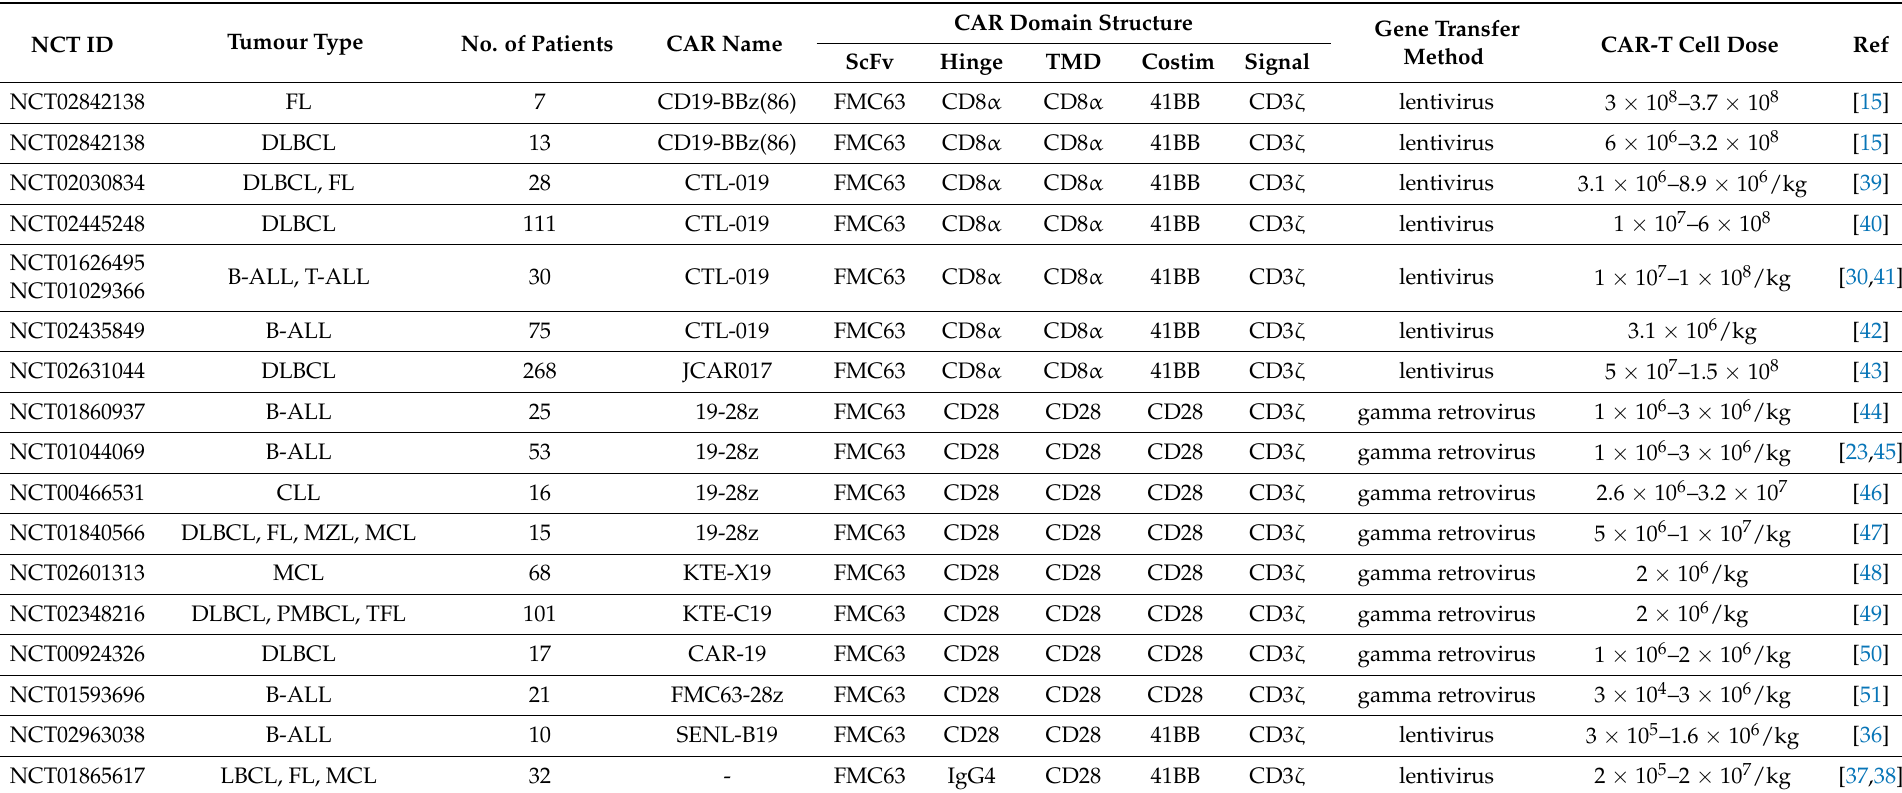
Table 1. Summary of FMC63 (CD19) CAR T cells in clinical trials with published clinical